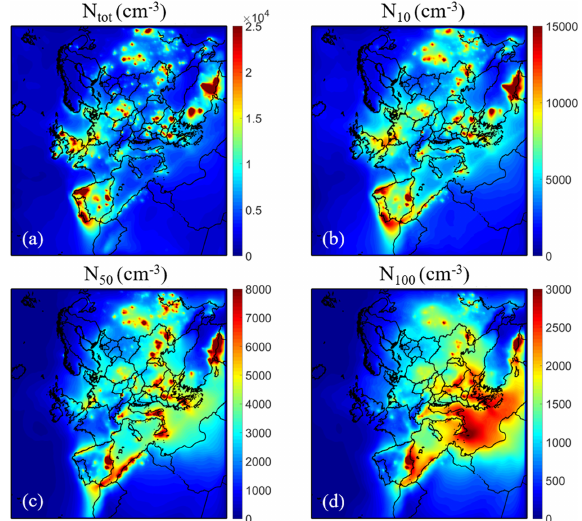
Figure 1. Average ground level number concentrations (in cm − 3 ) for the base case simulation from 5 June–8 July 2012 for (a) all par- ticles ( N tot ) and particles above (b) 10nm ( N 10 ), (c) 50nm ( N 50 ), and (d) 100nm ( N 100 ). Different scales are